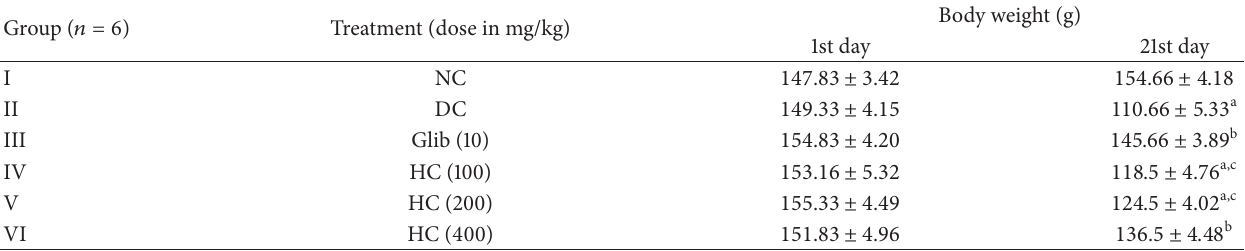
Table 4: Effect of HC on body weight in streptozotocin-induced diabetic